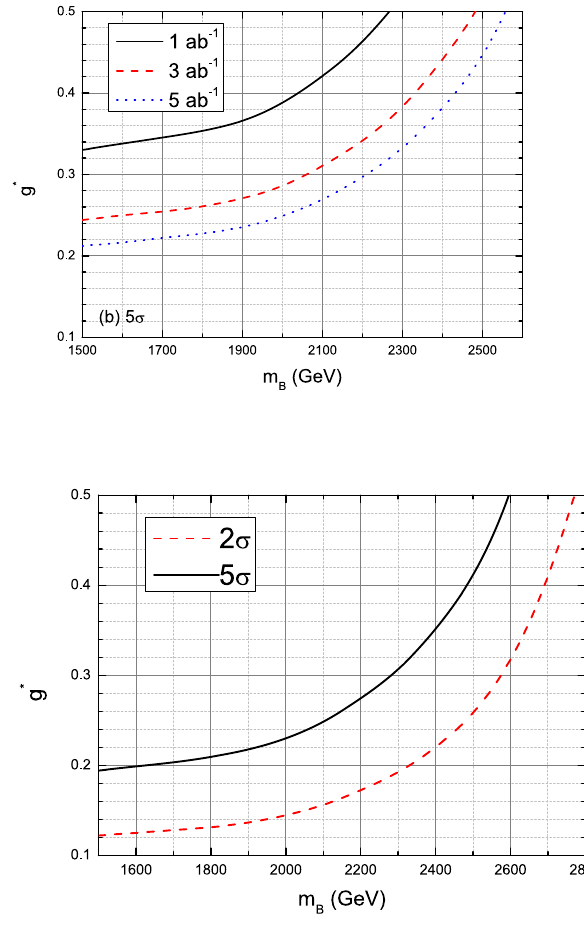
Fig. 8 Combined 2 σ exclusion limit and 5 σ discovery prospect con- tour plots for the signal in g ∗ − m B planes at the CLIC with an